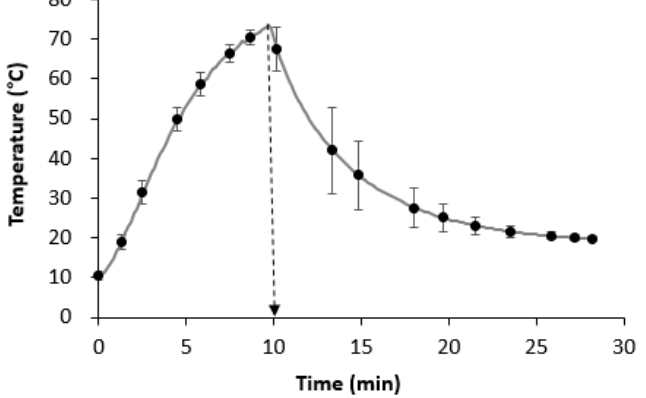
Figure 1. Temperature behavior over time during heat treatment of chicken meat samples cooked at 80 °C. The values are presented as the mean ± standard deviation of three replicates. The dashed arrow indicates the time needed to reach the temperature of 72 °C inside the sample.